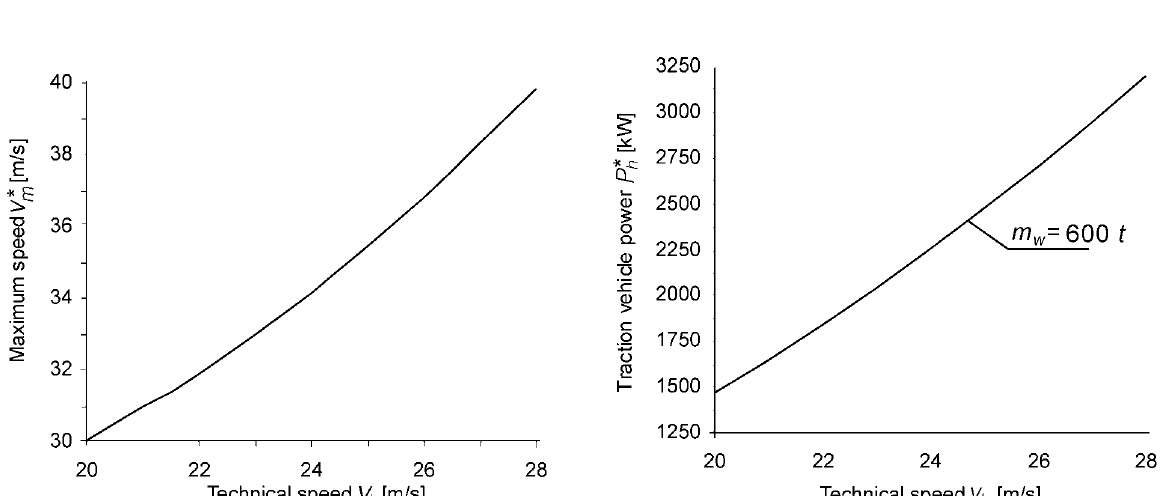
Fig 1. Variations of traction vehicle speed ∗ technical speed within segment 15 =